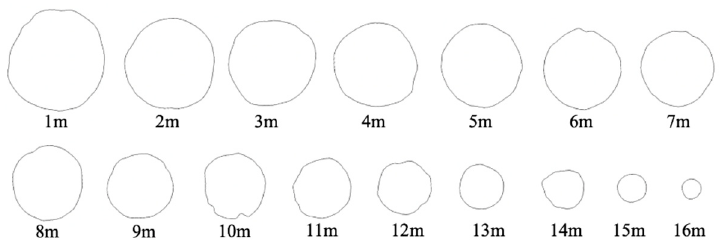
Figure 2. Contour curves of stem